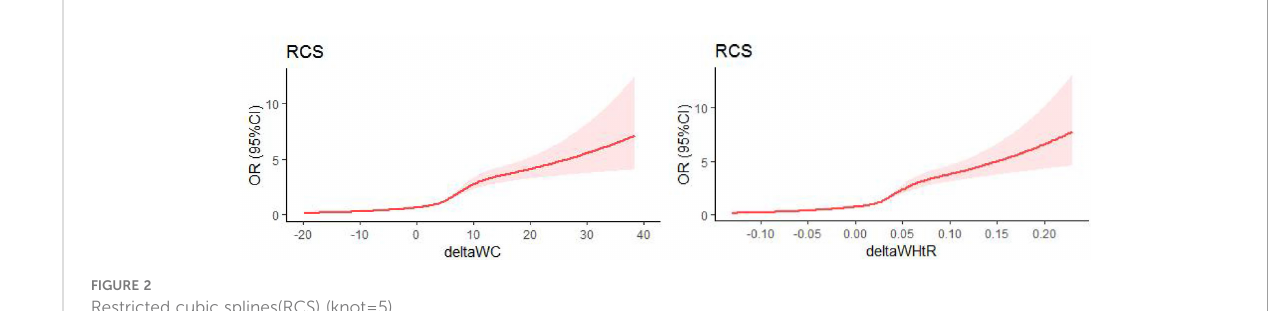
FIGURE 2 Restricted cubic splines(RCS) (knot=5).